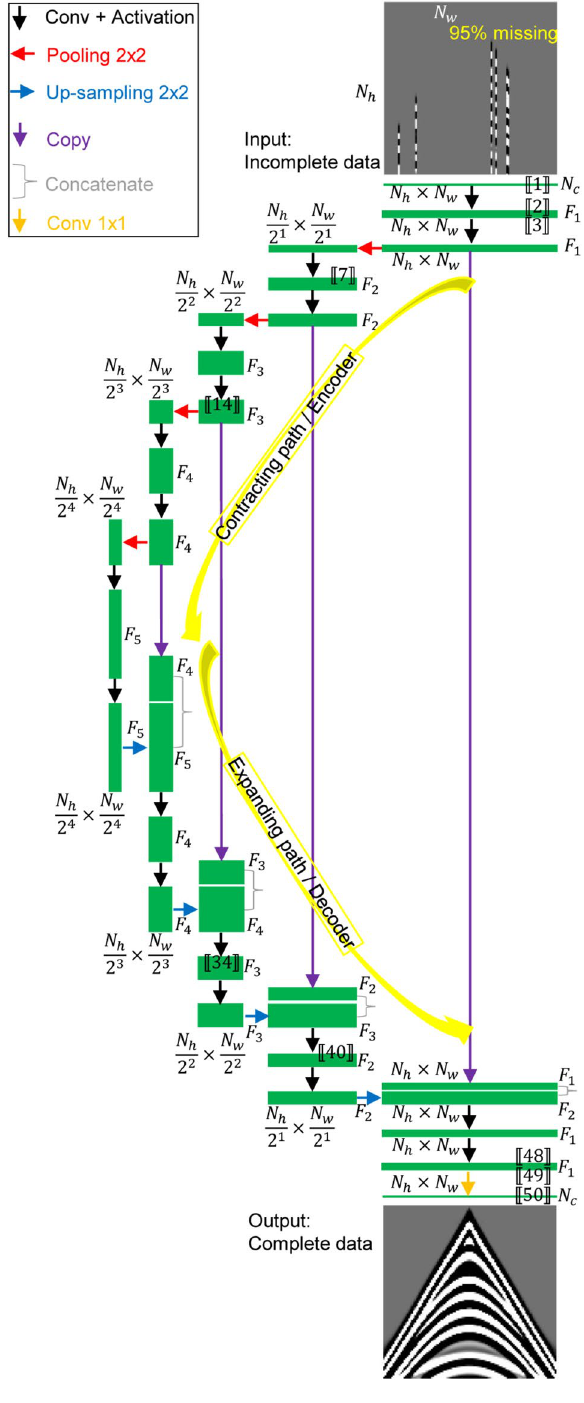
h w Figure 1. Network architecture at an example of × N N pixels in the lowest resolution. N h , N w , and N c are the 4 4 2 2 height, width, and the number of channels of the input data, respectively. Blocks show the calculated feature hierarchy. Each green box denotes multiple feature maps, and the number of feature maps (i.e., F i , i ∈ [1, 5] ) is marked on the right of the box. The height-width-size of a feature map is given around the box. The boxes with the same height have the same number of feature maps. The boxes with the same width indicate the same height-width-size of feature maps. The arrows and the right curly brace denote different operations. Numbers in [[ ⋅ ]] are labelled according to Table 1, which are in line with those shown in Fig.